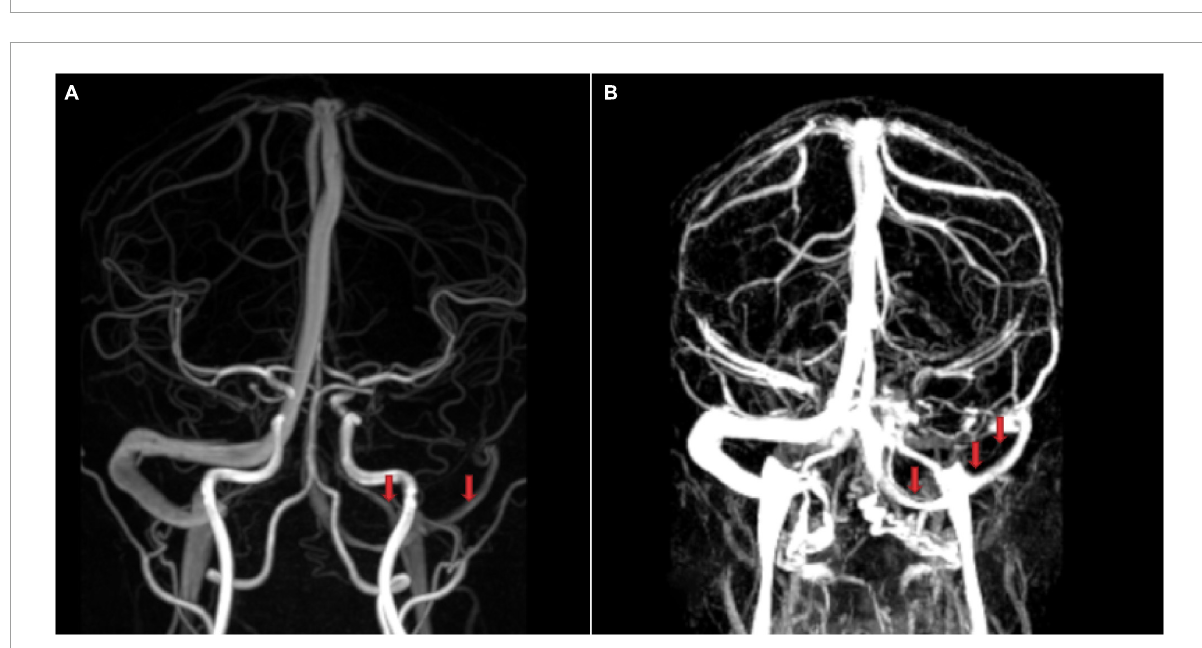
FIGURE2 Images of the cerebral venous sinus from a 28-year healthy man without cerebral venous system diseases or another clinical history. (A) Phase-contrast-magnetic resonance venography (MRV) and (B) contrast-enhanced (CE)-MRV. CE-MRV provides better visualization of slender venous sinuses and superficial cerebral veins, which is highly significant for morphological